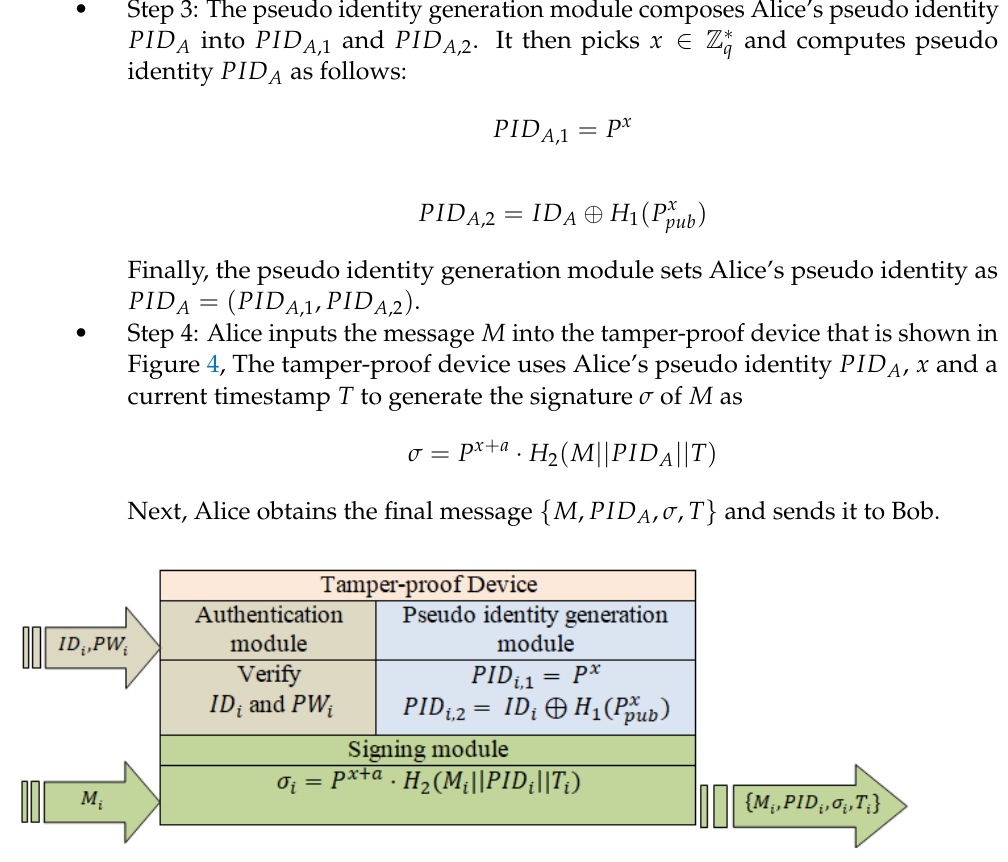
Figure 4. The tamper-proof device for Scheme II